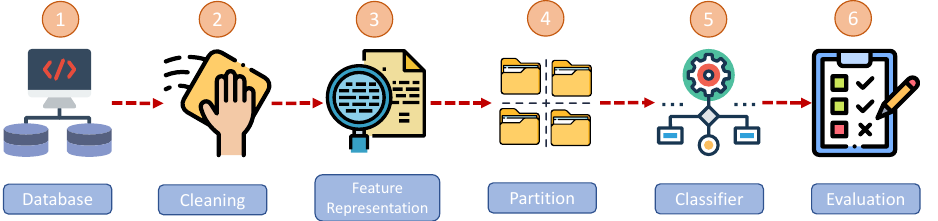
Figure 5. Flow diagram for the procedure of getting the classification results of the Xenopho- bia